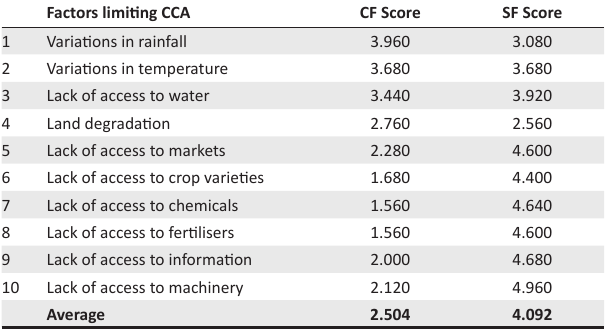
0 Percentage of respondents experiencing these FIGURE 2 : Factors constraining the adaptation of respondents. TABLE 1 : Scores of the factors constraining respondents from adapting to climate change. Factors limiting CCA CF Score